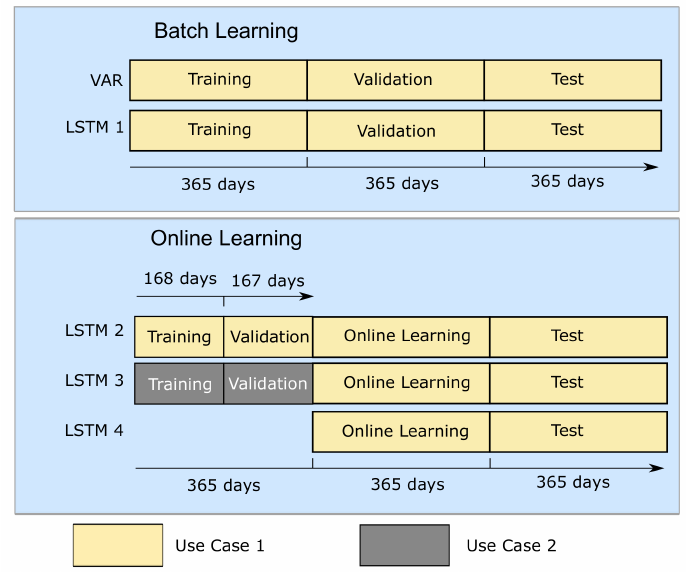
Figure 6. Used scenarios for benchmarking the performance of the different